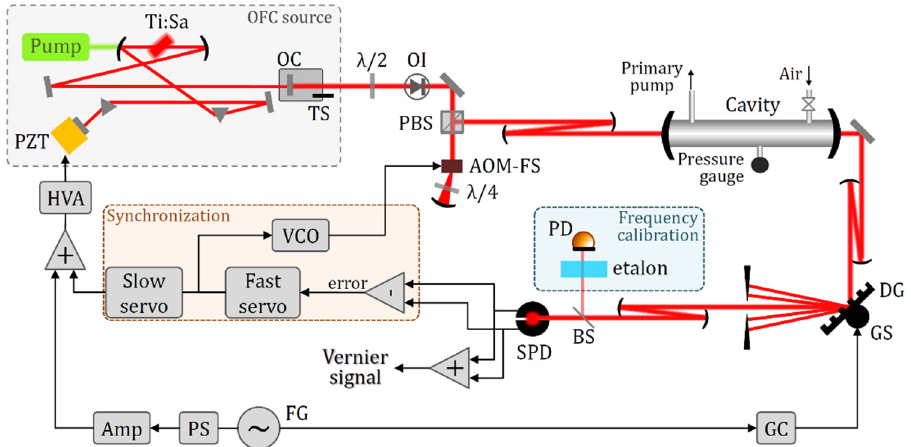
Figure 7. Schematic of the near-infrared CF-VS setup: PZT: piezo transducer; OC: output coupler; TS: translation stage; OI: optical isolator; λ /2: half-wave plate; PBS: polarizing beam splitter; λ /4: quarter-wave plate; AOM-FS: acousto-optic modulator frequency shifter; DG: diffraction grating; GS: galvo scanner; BS: beam splitter; PD: photodiode; SPD: split photodiode; VCO: voltage-controlled oscillator; HVA: high voltage amplifier; FG: frequency generator; GC: galvo controller; PS: phase shifter.